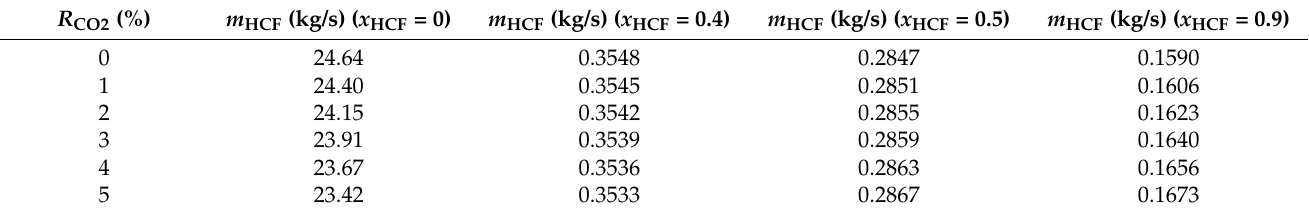
Table 3. The mass flow rate of heat-carrying fluid under different steam